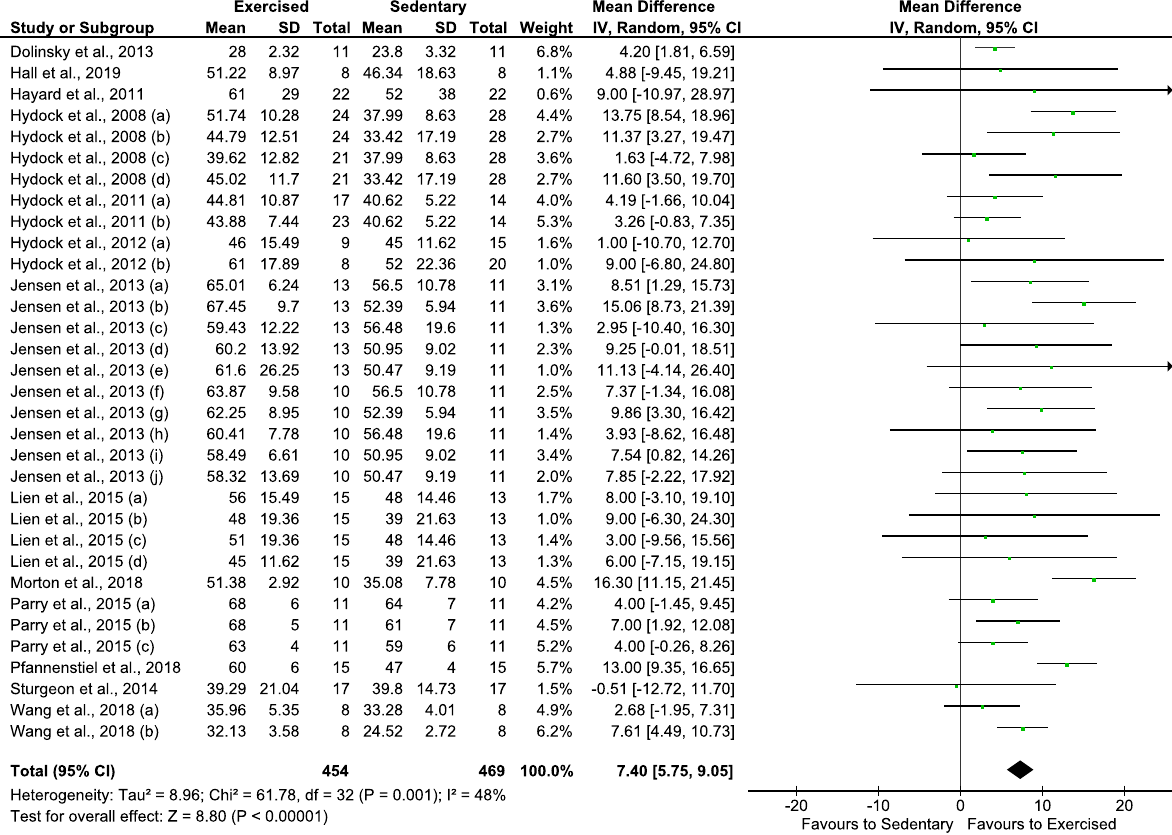
Figure 3. Overall effects of exercise training in fractional shortening of cardiac function of experimental models of doxorubicin-induced cardiomyopathy. Hydock et al., 2008 treadmill group ( a ) at day 5 and ( b ) at day 10, ( c ) wheel running group at day 5 and ( d ) at day 10; Hydock et al., 2011 ( a ) treadmill group, ( b ) wheel running group; Hydock et al., 2012 ( a ) 15 mg/kg and ( b ) 20 mg/kg cumulative dose of DOX; Jensen et al., 2013 treadmill group ( a ) at day 1, ( b ) at day 3, ( c ) at day 5, ( d ) at day 7 and ( e ) at day 9, wheel running group ( f ) at day 1, ( g ) at day 3, ( h ) at day 5, ( i ) at day 7 and ( j ) at day 9; Lien et al., 2015 treadmill group receiving ( a ) 10 mg/ kg and ( b ) 15 mg/kg cumulative dose of DOX, wheel running group receiving ( c ) 10 mg/kg and ( d ) 15 mg/kg cumulative dose of DOX; Parry et al., 2015 wheel running group ( a ) at day 1, ( b ) at day 3 and ( c ) at day 5; Wang et al., 2018 mice ( a ) C57BL/6 and ( b ) Athymic Swiss